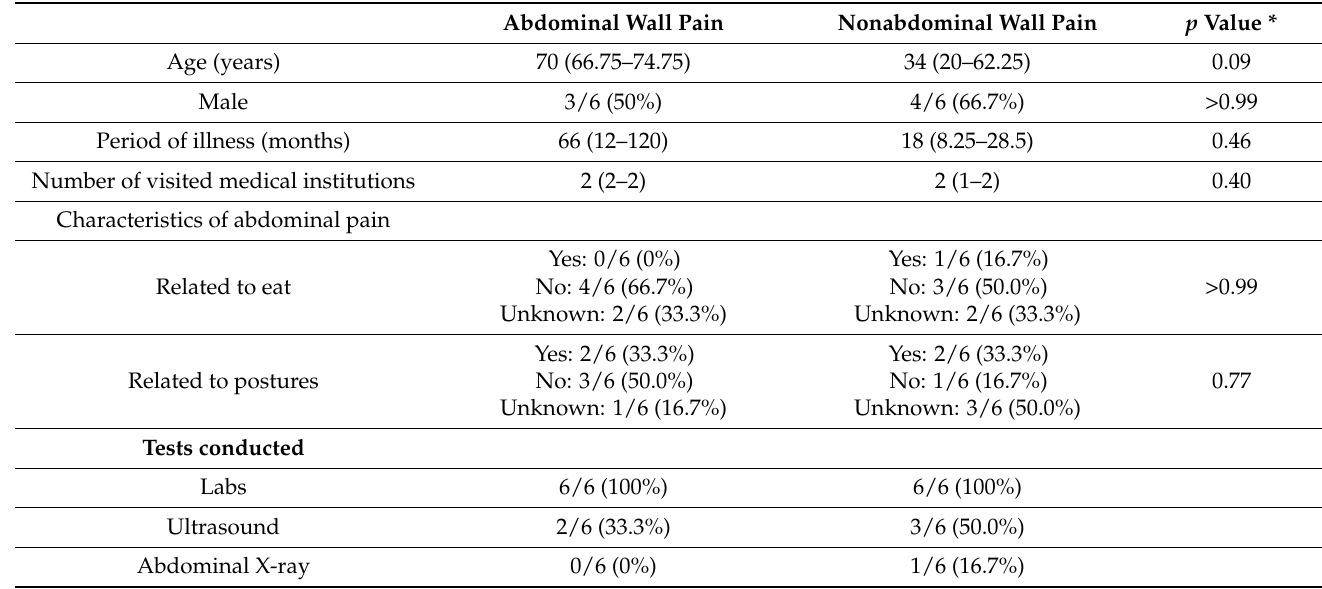
Table 2. Twelve patients with undiagnosed abdominal